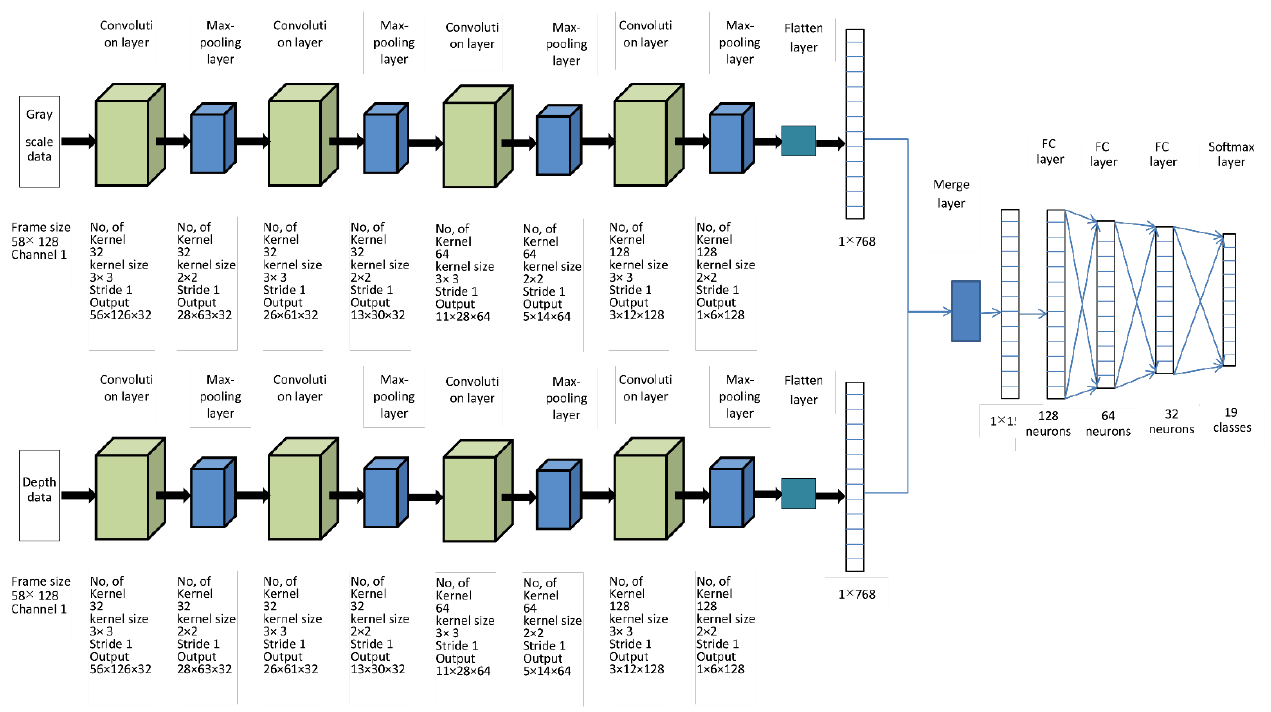
Fig. 2. The architecture of CNN used for feature extraction and labelling of